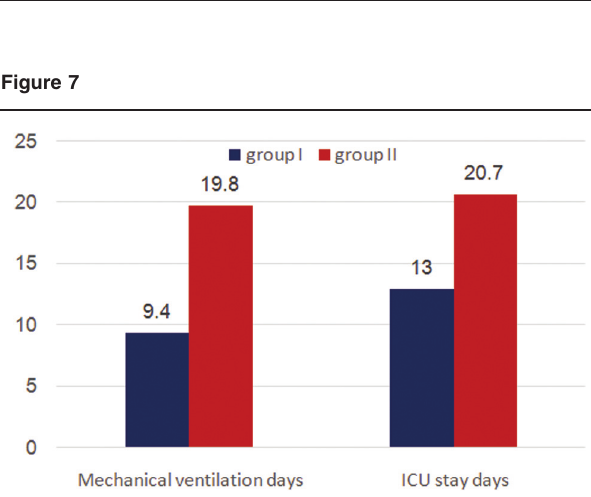
Comparison between MV days and ICU stay days.